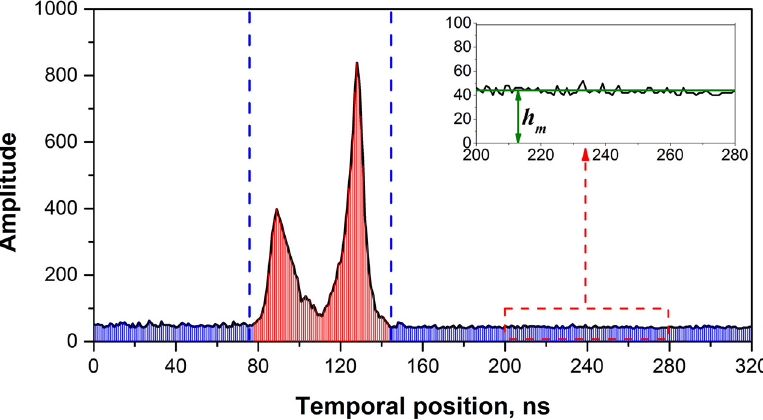
Figure 3. Determination of sigma in the Gaussian filter through the noisy segment. The green line in this figure represents the horizontal line of an invalid waveform after filtering; h m is the calculated average value of the amplitude of the noisy